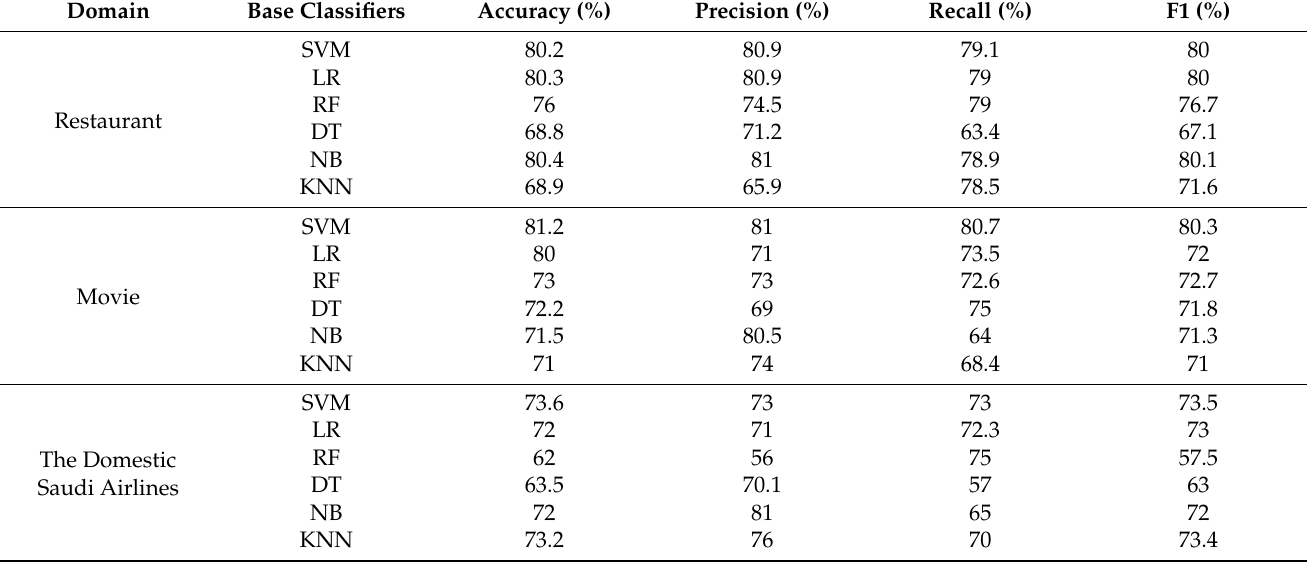
Table 6. Performance comparison of baseline classifiers on three various